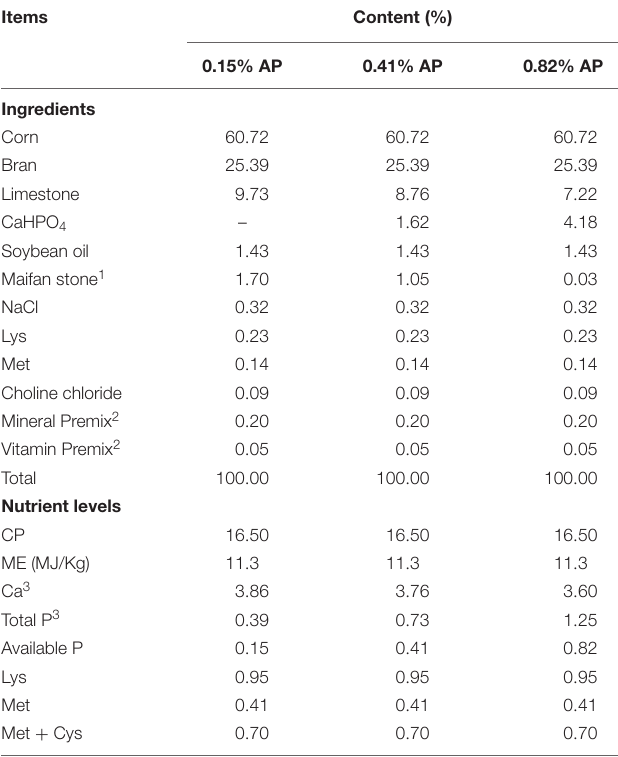
TABLE 1 | Composition of experimental diets (air-dry